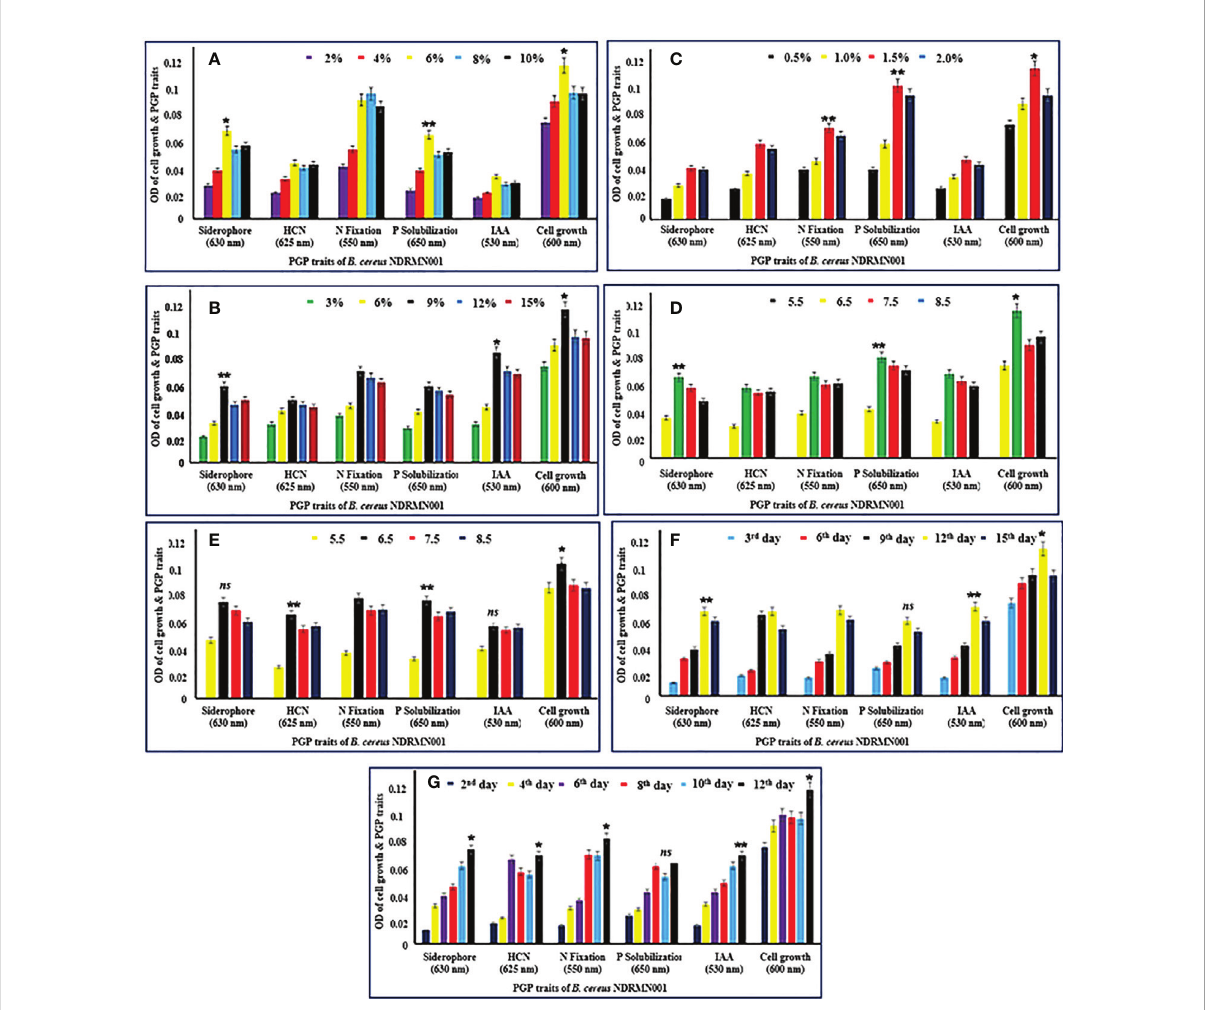
FIGURE 3 Optimization of growth parameters for PGP activities of B. cereus NDRMN001. The mentioned values are mean and standard error ( ± SE) of triplicates. * Signi fi cantly differs ( p < 0.05), ** signi fi cantly differs ( p < 0.001) from others ns, Not signi fi cant. (A) Various percentage of glucose. (B) Various percentage of tryptophan. (C) Various percentage of tricalcium phosphate. (D) Various pH. (E) Various temperature. (F) Days of incubation. (G) PGP trait production under optimized conditions at different days of